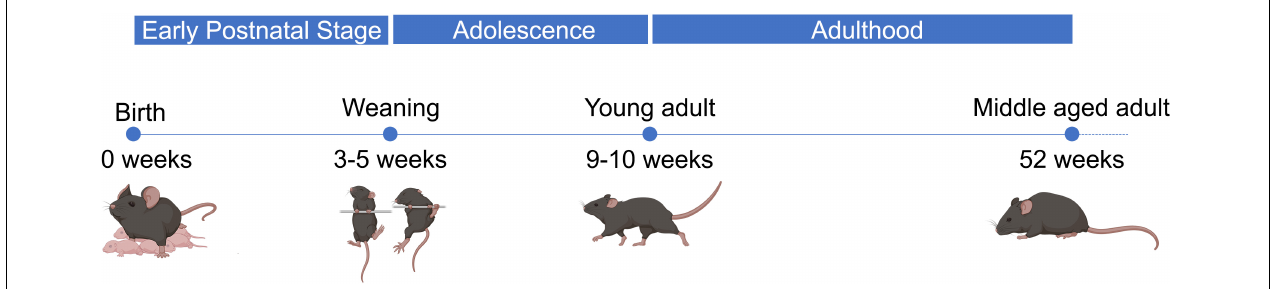
FIGURE 1 | Developmental stages throughout lifetime of wild-type mice. Wild-type male mice go through several developmental stages during their lifetime. Up to 4 weeks after birth, which is the early postnatal period, the pups are completely dependent on their mother for food and protection. During this time-period the pups gain weight with an increasing rate. After 4 weeks until 9–10 weeks, male mice mature sexually and become more aggressive. Through this period, which is known as adolescence, the mice become more independent, their weight is still increasing, and they experience many behavioral changes. Finally, 10 weeks after birth wild-type male mice have fully transitioned to adulthood. Their bodies have stopped gaining weight, they are sexually active, and they mature regarding their behavior. Around 1 year after their birth, inbred mice begin to show signs of functional and behavioral decline, while the majority of them have reached the post-productive era of their life.